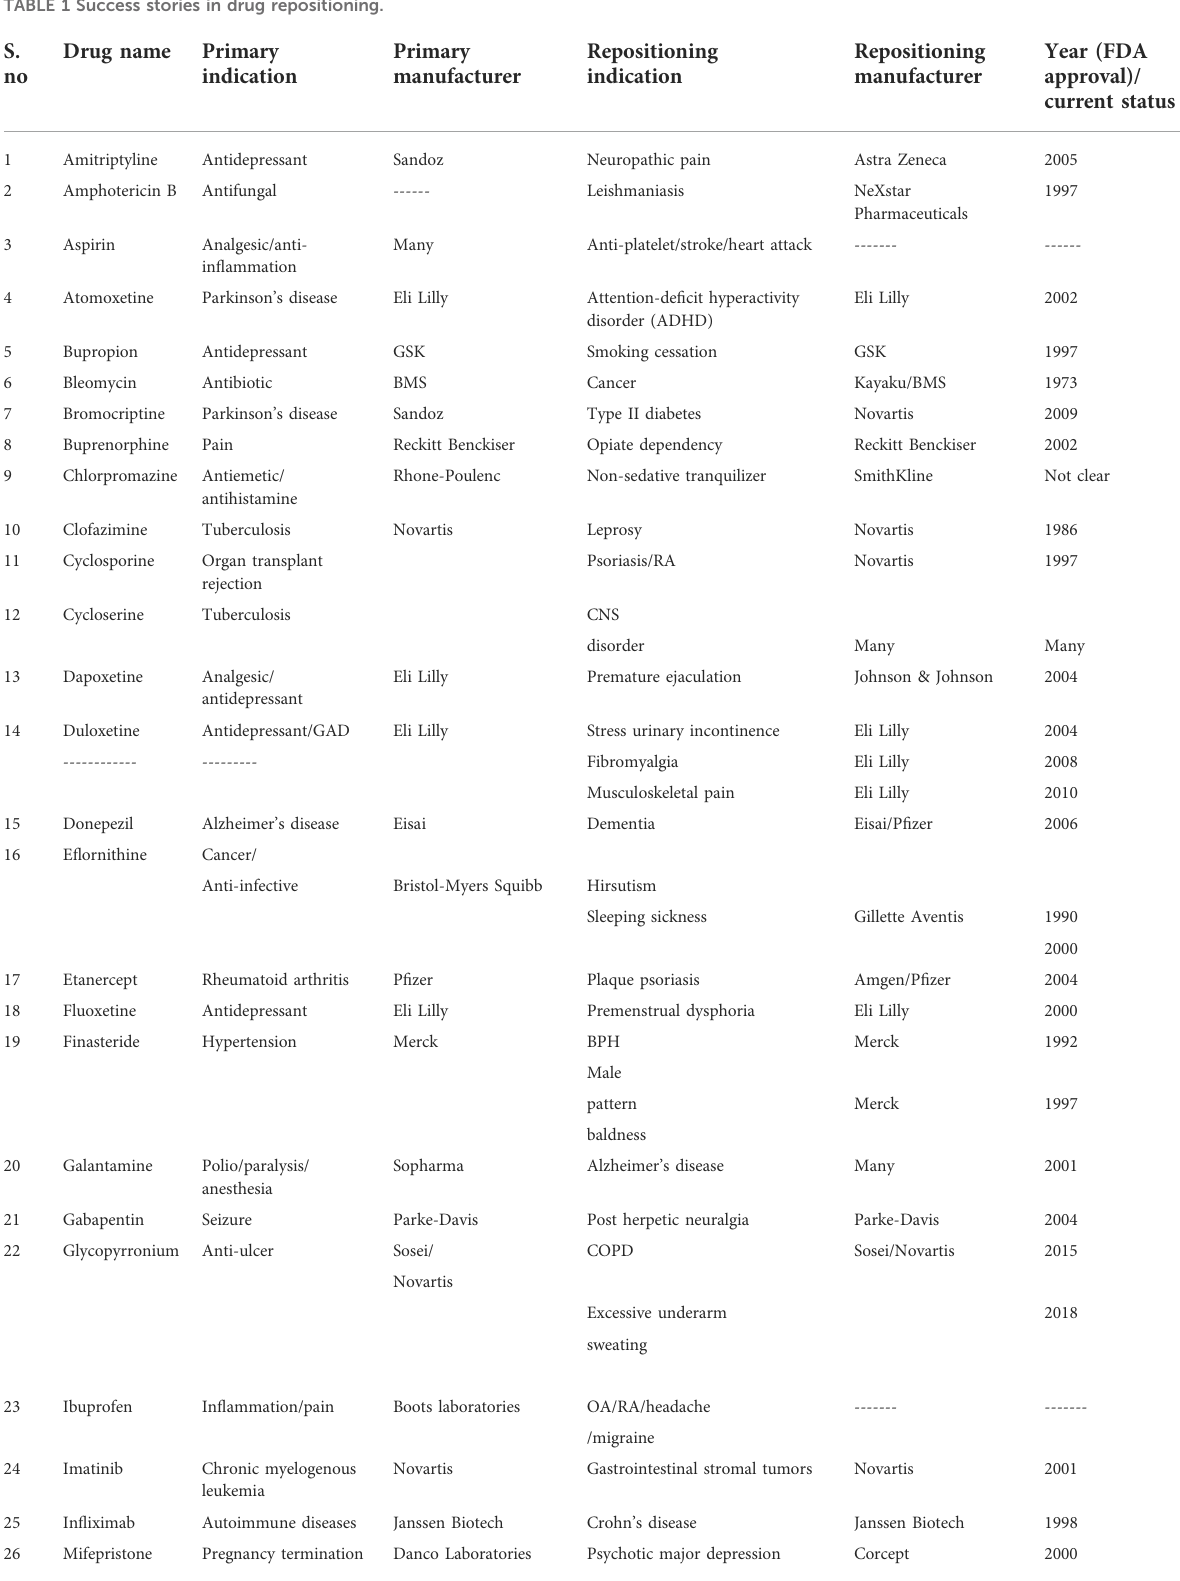
TABLE 1 Success stories in drug